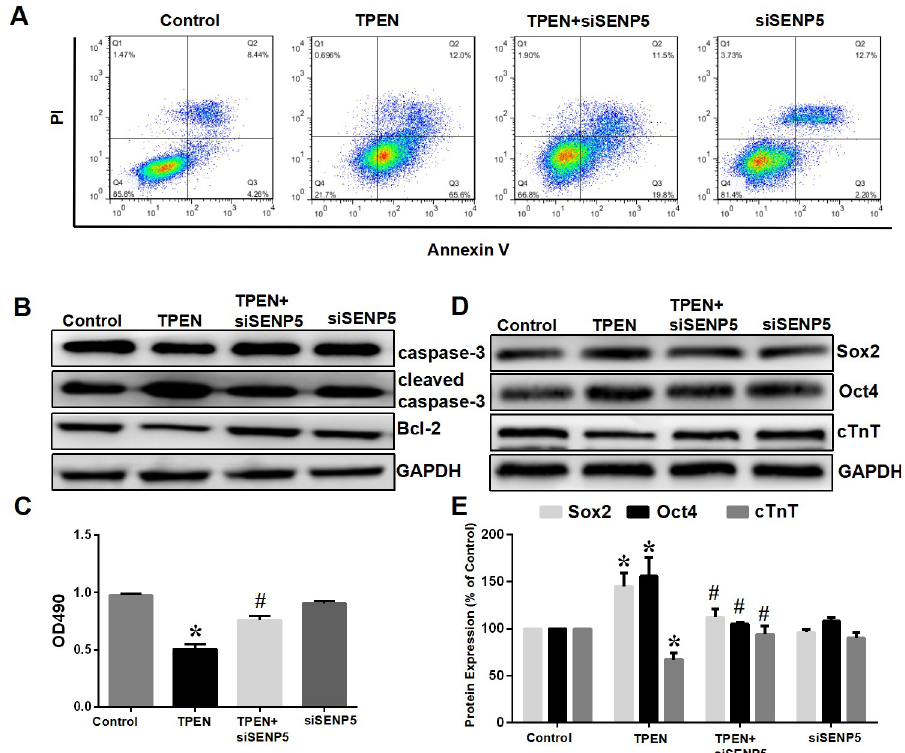
Fig 7. SENP5 knockdown antagonizes the effect of TPEN on apoptosis and induced abnormal differentiation of hiPSCs. (A) Flow cytometric analysis of the apoptotic state (n = 3). (B) Western blot analysis of caspase-3, active caspase-3 and Bcl-2 levels in cardiac progenitor cells. Viability of hiPSC-CMs with siSENP5 was increased slightly compared with zinc-deficient hiPSC-CMs (n = 6). (C) CCK8 assay of cell viability. TPEN (10 μ M) significantly decreased hiPSC-CM viability, which was abrogated by siSENP5 (n = 6). � P < 0.05 vs. control; # P < 0.05 vs. TPEN. (D) Western blotting of Sox2, Oct4 and cTnT, protein expression. In the zinc-deficient state, expression levels of cTnT were decreased in hiPSC-CMs, while the expression level of stem cell marker Sox2 and Oct4 were increased, which were abrogated by siSENP5. (E) Summarized data of (B). Values are presented as the mean ± SD. Statistical significance was analyzed by Tukey’s test. � P < 0.05 vs. control; # P < 0.05 vs. TPEN. The development of the heart is a complex process regulated by multiple genes and sig- naling pathways. The importance of SUMOylation is also underlined by the observation of cardiac abnormalities. The knockdown of SUMO1 in mice leads to atrial and ventricular septal defects [30]. SUMO-1 can prevent the negative effects of SERCA2a activity caused by the hypertrophied and failing myocardium [31]. The studied confirmed SUMO1 impact heart development. In this study, free SUMO1 and conjugated SUMO1 were founded to be differentially expressed during the heart development of fetal and neonatal mice. The expression of conjugated SUMO1 was gradually decreased though the entire cardiac devel- opmental process, while the level of free SUMO1 was increased. It was also confirmed that the expression level of SENP5 protein was decreased during the heart development. This indicates that SENP5 could potentially be related to SUMO1 deconjugation to maintain the dynamic balance of SUMOylation and deSUMOylation, and play an important part in heart development. Previous studies revealed that the ability of myocardium differentiation grad- ually diminishes following the developmental process. It indicated that SENP5 may be asso- ciated with the myocardial viability and differentiation. Further research will be carried out in the following experiments.